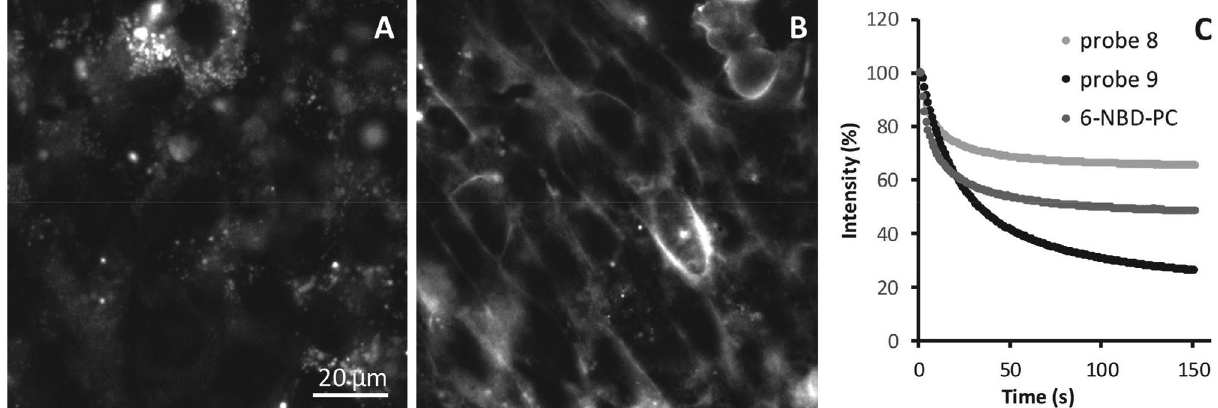
Figure 3. LA4 cells labeled with (A) probe 8 and (B) probe 9 for 5 min at 10 nM concentration. (C) Bleaching of probes with time; probe 8 (light grey circles), probe 9 (black circles) and commercial 6-NBD-PC from Avanti Polar Lipids (dark grey circles). The concentration of the probes on cells, where the bleaching characteristics of probes are presented, was 100